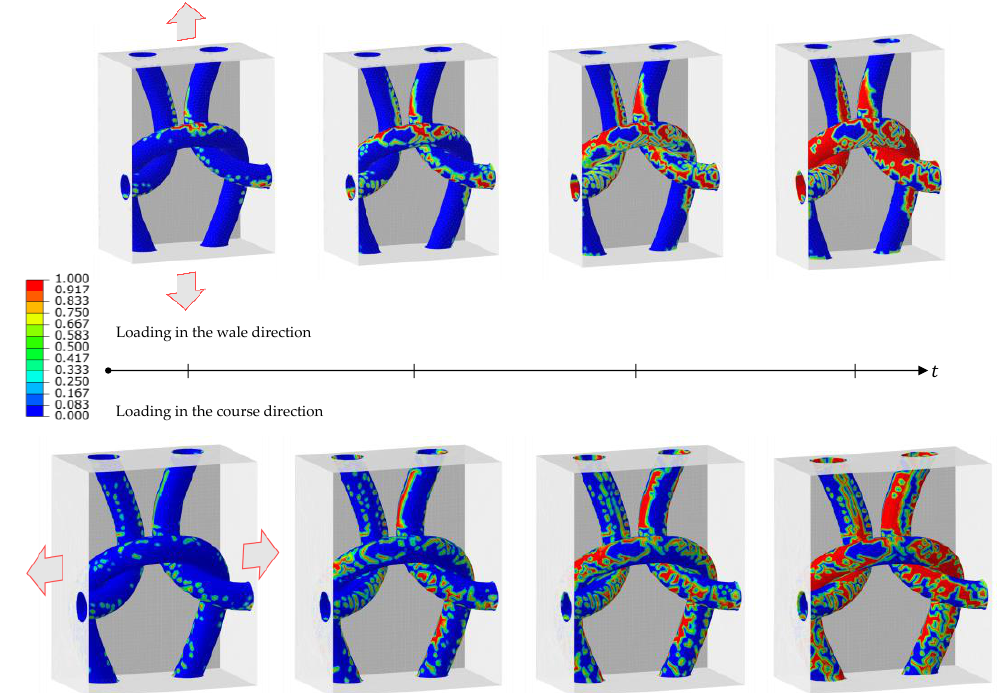
Figure 9. Cohesive damage evolution at the fiber tow/matrix interfaces of the knitted composite RVE during tension in the principal directions.